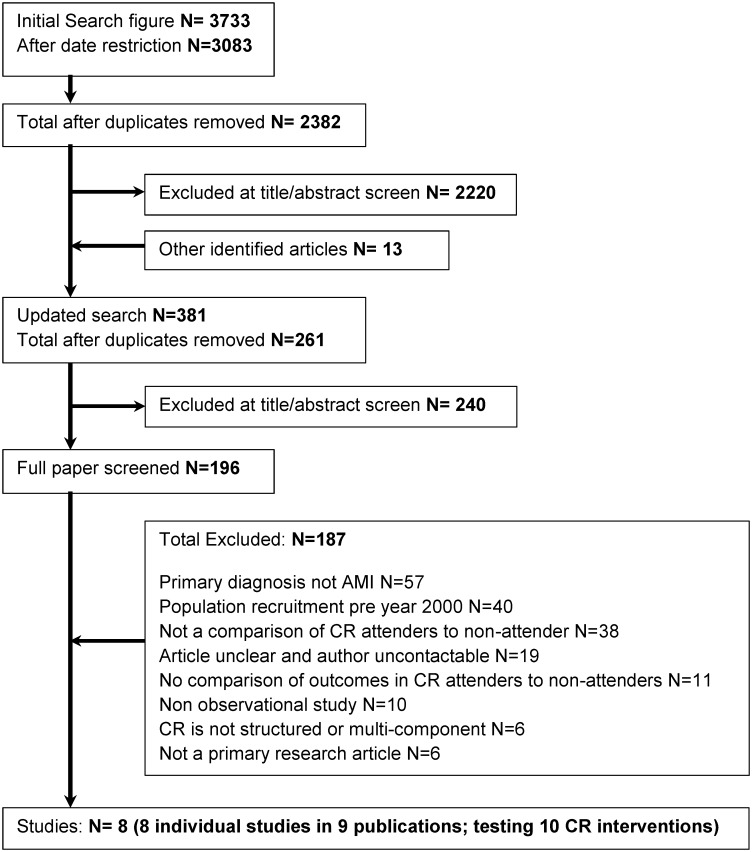
Prisma flow diagram.